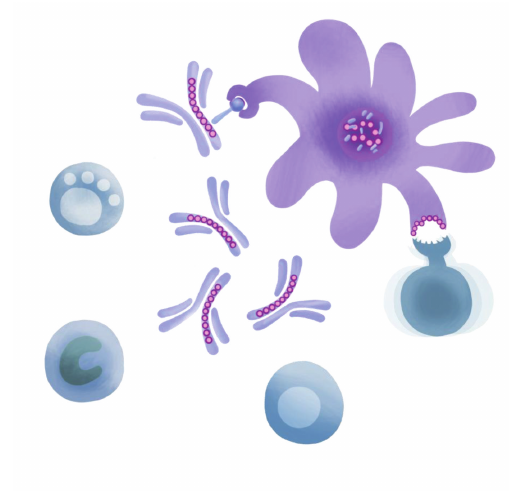
Figure 1: Potential IgG (and Tregitope) Mechanisms of Action. From left to right, IVIG has been demonstrated to affect the cells of the innate and adaptive immune system including NK cells, macrophages, B cells, T cells, dendritic cells and other antigen presenting